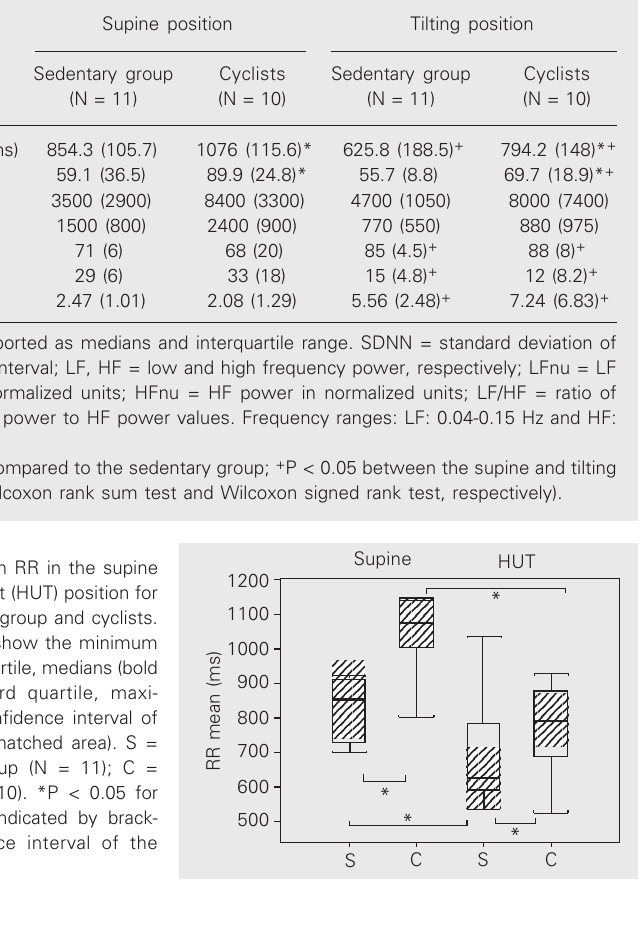
Table 2. Comparison of heart rate variability parameters in time and frequency do- mains in the supine and tilting position. Supine position Tilting position